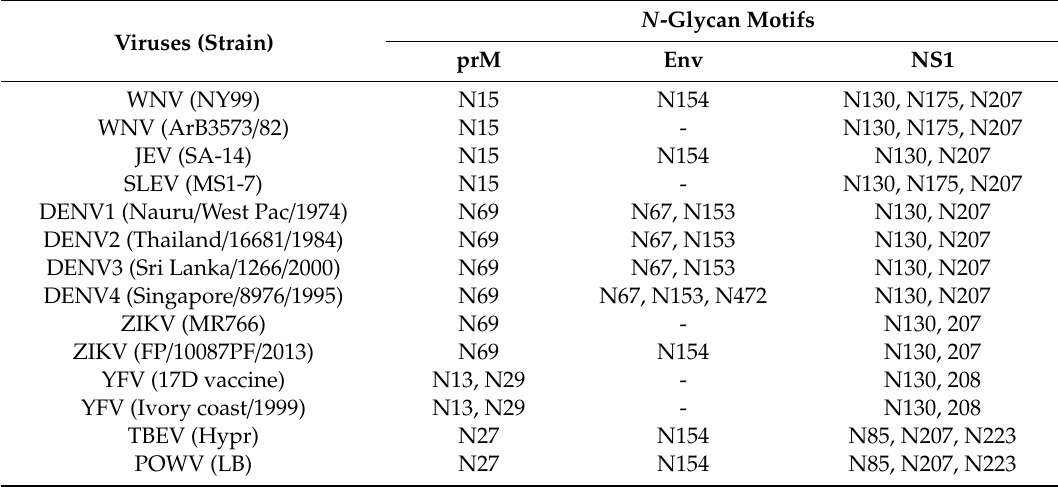
Table 2. The comparison of N -glycan motifs in di ff erent flaviviruses. Viruses